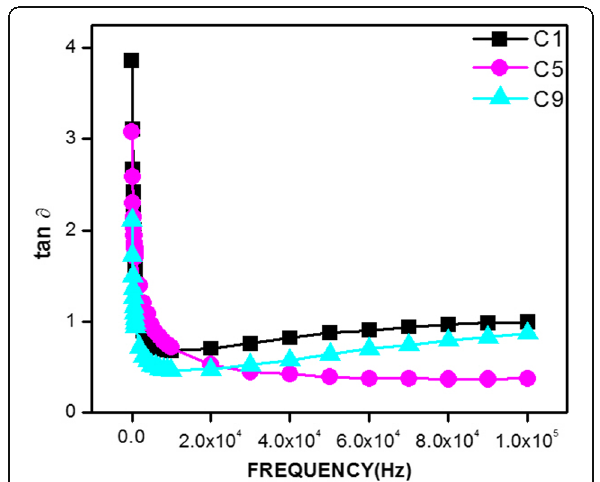
Fig. 6 Variation of tan ∂ with frequency for C1( x = 0.1, y = 0.45), C5( x = 0.5, y = 0.25), and C9( x = 0.9, y = 0.05)